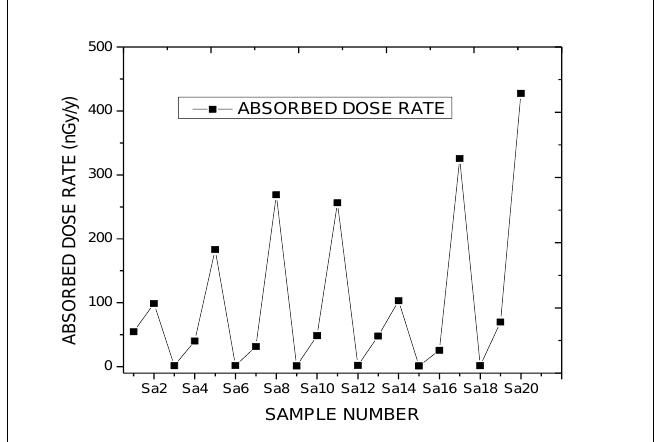
Figure 3: A Line Graph Showing Absorbed Dosed Rate for the Collected Samples.